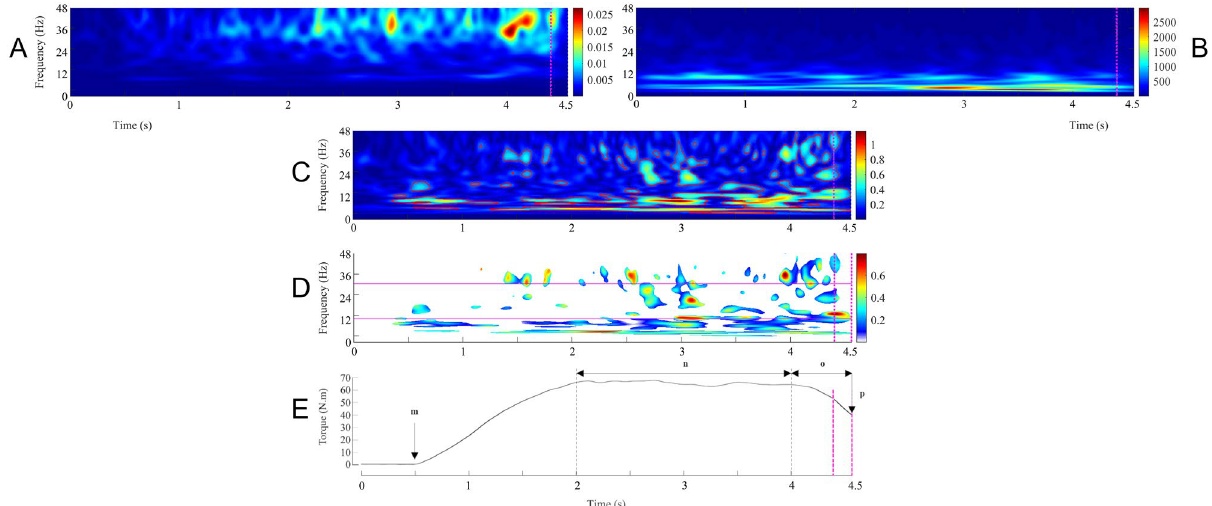
Figure 6. Illustration of the different steps involved in the calculation of time–frequency wavelet-based corticomuscular coherence during shortening contractions, preceded by a period of isometric preactivation, in a typical subject. The pink vertical dashed lines represent the 200 ms window preceding the neurostimulation chosen for the analyse. First row: mean wavelet auto-spectra of the EMG time series from the soleus ( A ) and the Cz EEG ( B ). Second row: wavelet cross-spectrum between the soleus EMG and the Cz EEG time series; the red contours identify the areas in the time–frequency plane where the correlation between the soleus EMG and the Cz EEG signals is statistically significant ( C ). Third row: wavelet magnitude-squared coherence between the soleus EMG and the Cz EEG time series where the correlation between the soleus EMG and the Cz EEG signals is statistically significant. The pink horizontal solid lines represent the [13–32] beta-band. ( D ) In each frequency band ( β : 13–32 Hz; γ : 33–52 Hz), the corticomuscular coherence value was defined as the volume under the magnitude-squared coherence values in the 0.2-s time window of interest preceding the neurostimulation, where the correlation between the soleus EMG and the Cz EEG time series was detected as significant on the wavelet cross-spectrum. Fourth row: mean torque produced during the corresponding contractions ( E ). G.m. beginning of the isometric preactivation, G.n. 50% EMG SOL isometric preactivation, G.o. 50% EMG SOL anisometric contraction, G.p. neurostimulation